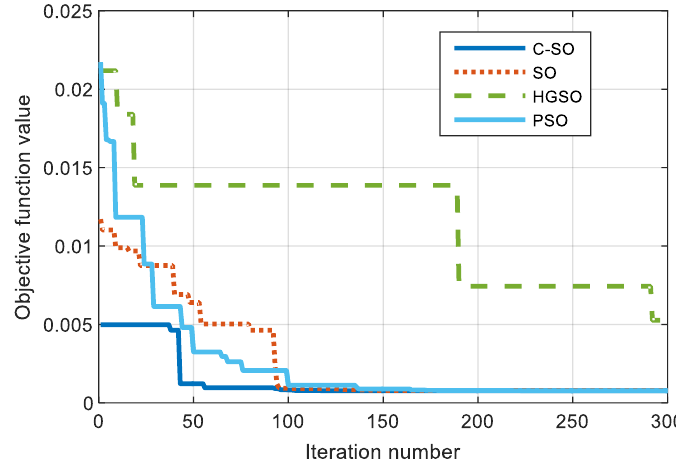
Figure 11. Convergence curve of C-SO versus different algorithms.